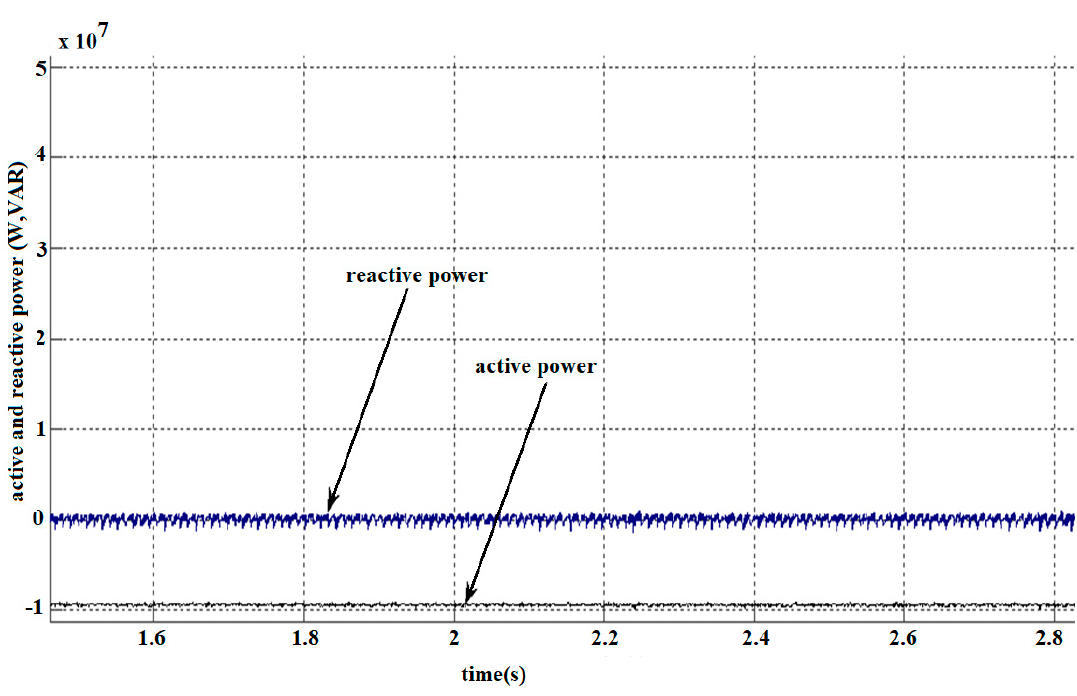
Figure 33. Active and reactive power at the node.